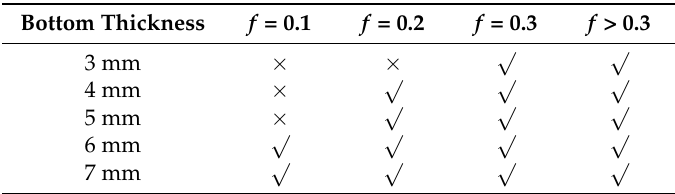
Figure 8. The simulation results of the extrusion process with different friction coefficient and bottom thickness. Table 3. The simulation results of the extrusion process with different parameters ( × : Cracked, √ : Uncracked).